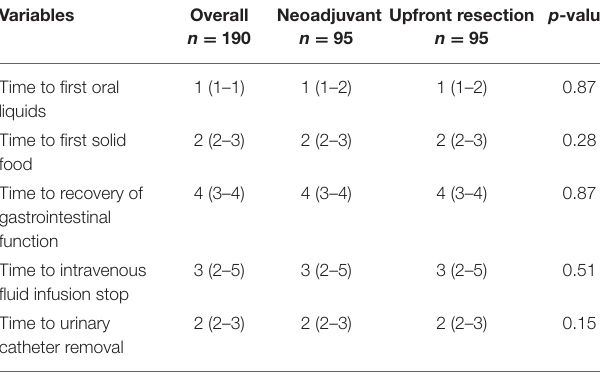
TABLE 4 | Postoperative functional recovery